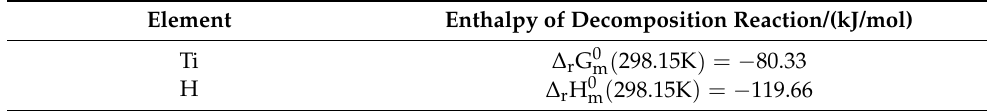
Table 10. Reaction enthalpy parameters of Ti and H.